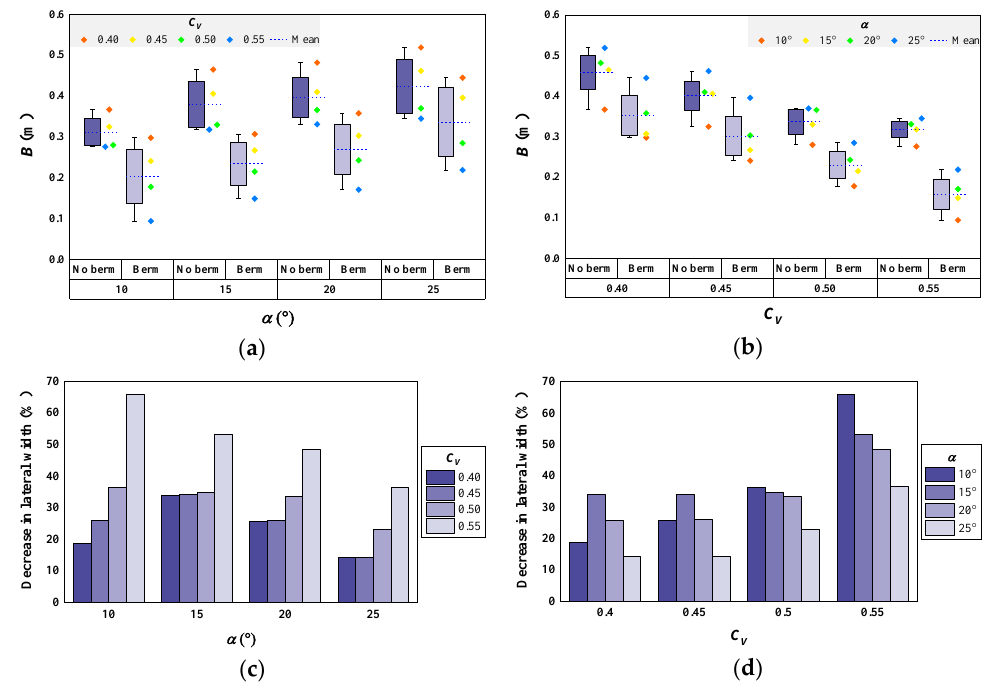
Figure 7. ( a ) Lateral width according to α (when C V = 0.40 – 0.55); ( b ) lateral width according to C V (when α = 10° – 25°); ( c ) percentage decrease in lateral width due to berm according to α (when C V = 0.40 – 0.55); ( d ) percentage decrease in lateral width due to berm according to C V (when α = 10° – 25°).